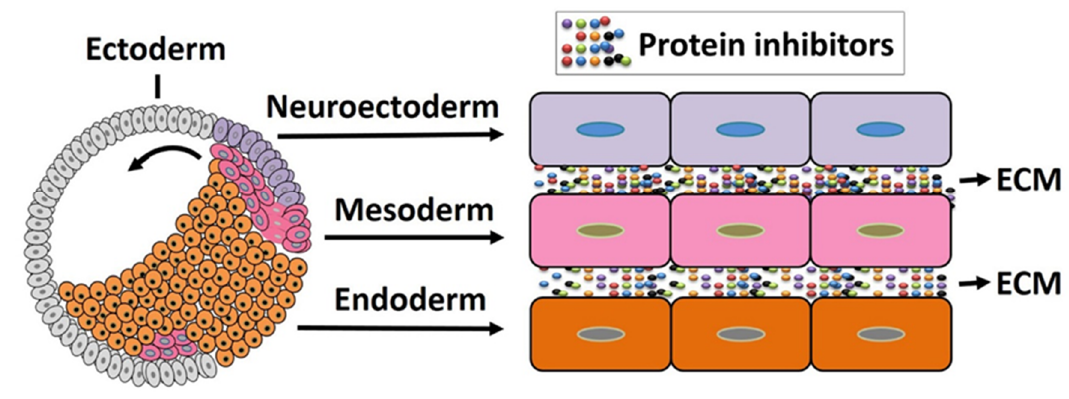
Figure 3. Early gastrulation in amphibian embryos. The dorsal mesoderm (organizer) cells initiate migration from the dorsal blastopore lip and establish primary germ layers. The involuting cells release several protein inhibitors that modify the surrounding cells’ fate.